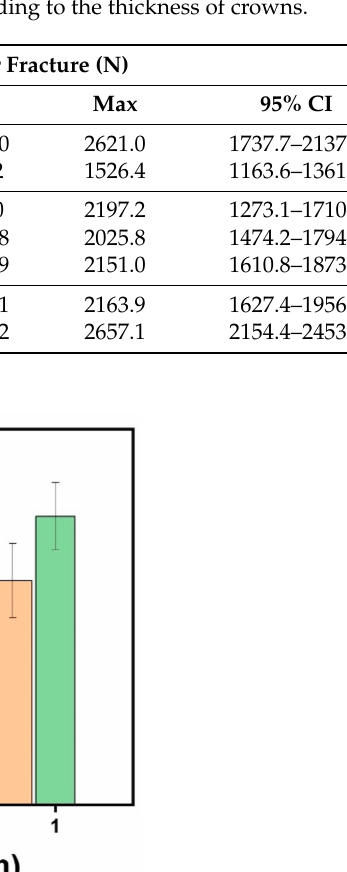
Table 3. The mean fracture resistance according to the thickness of crowns.